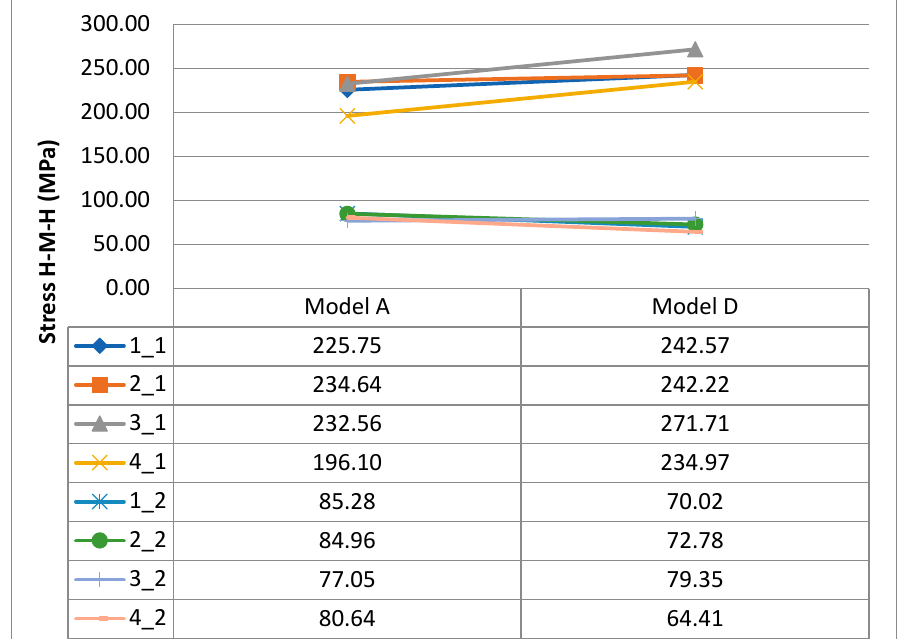
Figure 12. Compared stress values in the area of the integrated lip in the analyzed models. Figures 13 and 14 show the distribution of displacement in the Y-axis in the analyzed designs. The analysis of such a displacement distribution in the Y-axis is important for the reduction in circumferential backlash in a gear pump casing. In the investigated calcula- tion cases, the circumferential backlash compensation is better for higher values of dis- placements in the Y-axis. In such case, the compensation lip presses against the gears on the pressure side with greater force.